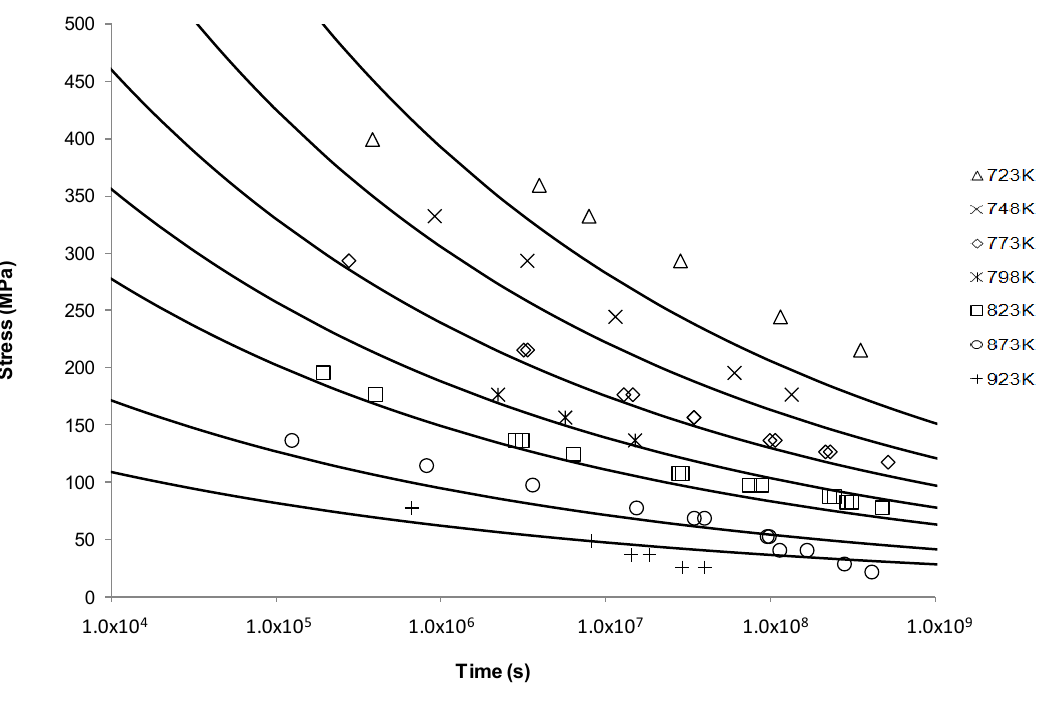
Figure 5. The Manson-Succop’s stress vs . time to fracture predictive curves using Grade 22 Steel creep